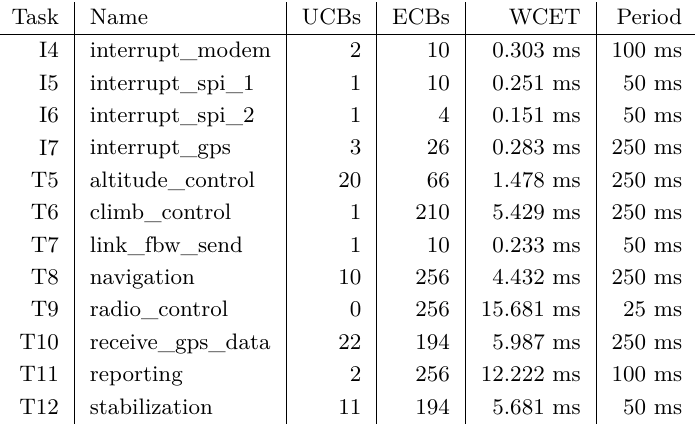
Table 1 Execution times, periods and number of UCBs and ECBs for the tasks from PapaBench. (ms = milisecond)